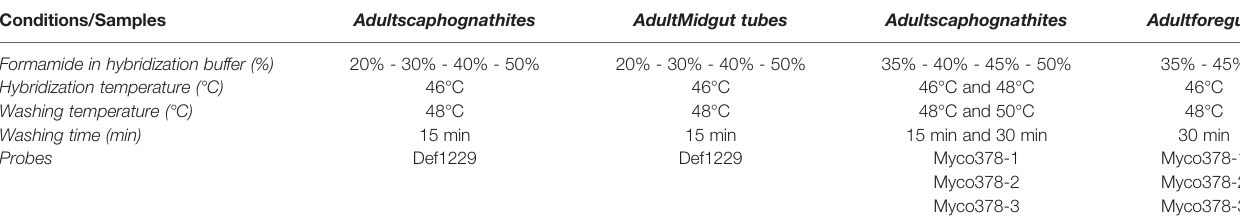
TABLE 3 | Conditions used in stringency tests performed for probe validation.